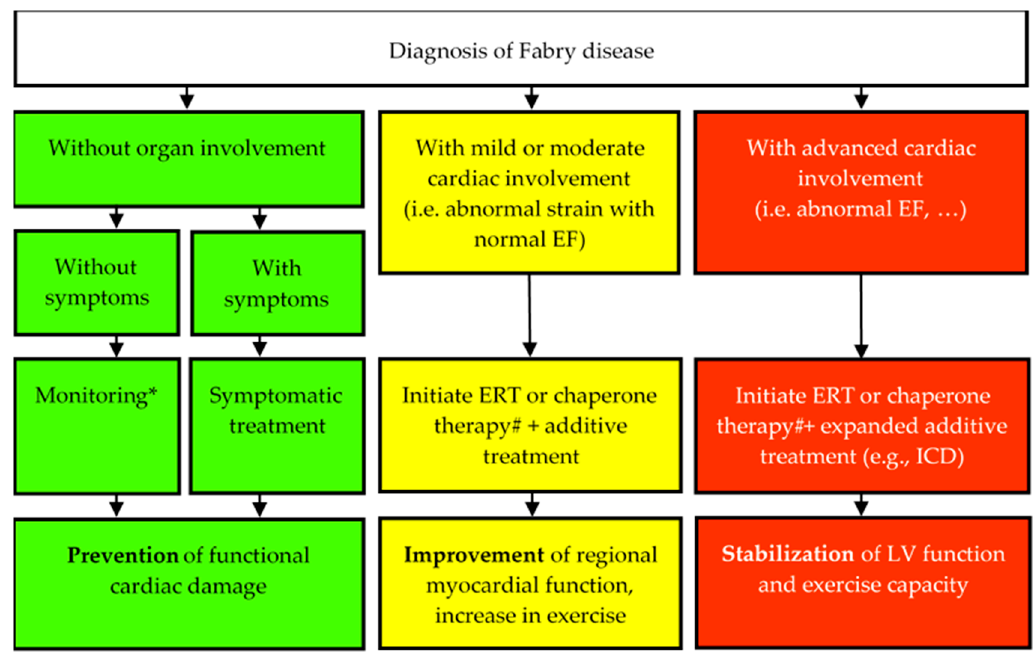
Figure 2. Current treatment algorithm for Fabry cardiomyopathy (adapted with permission from Weidemann F. et al. The Fabry cardiomyopathy: models for the cardiologist. Annu Rev Med 2011; 62: 59-67. Copyright © 2021, Marketplace TM . #: only in patients with Migalastat-amenable GLA mutations possible. EF: ejection fraction, ERT: Enzyme replacement therapy, ICD: implanted cardioverter defibrillator, LV: left ventricular. * e.g., echocardiography, Holter electrocardiography (ECG). All established diagnostic tests should be performed one a year.